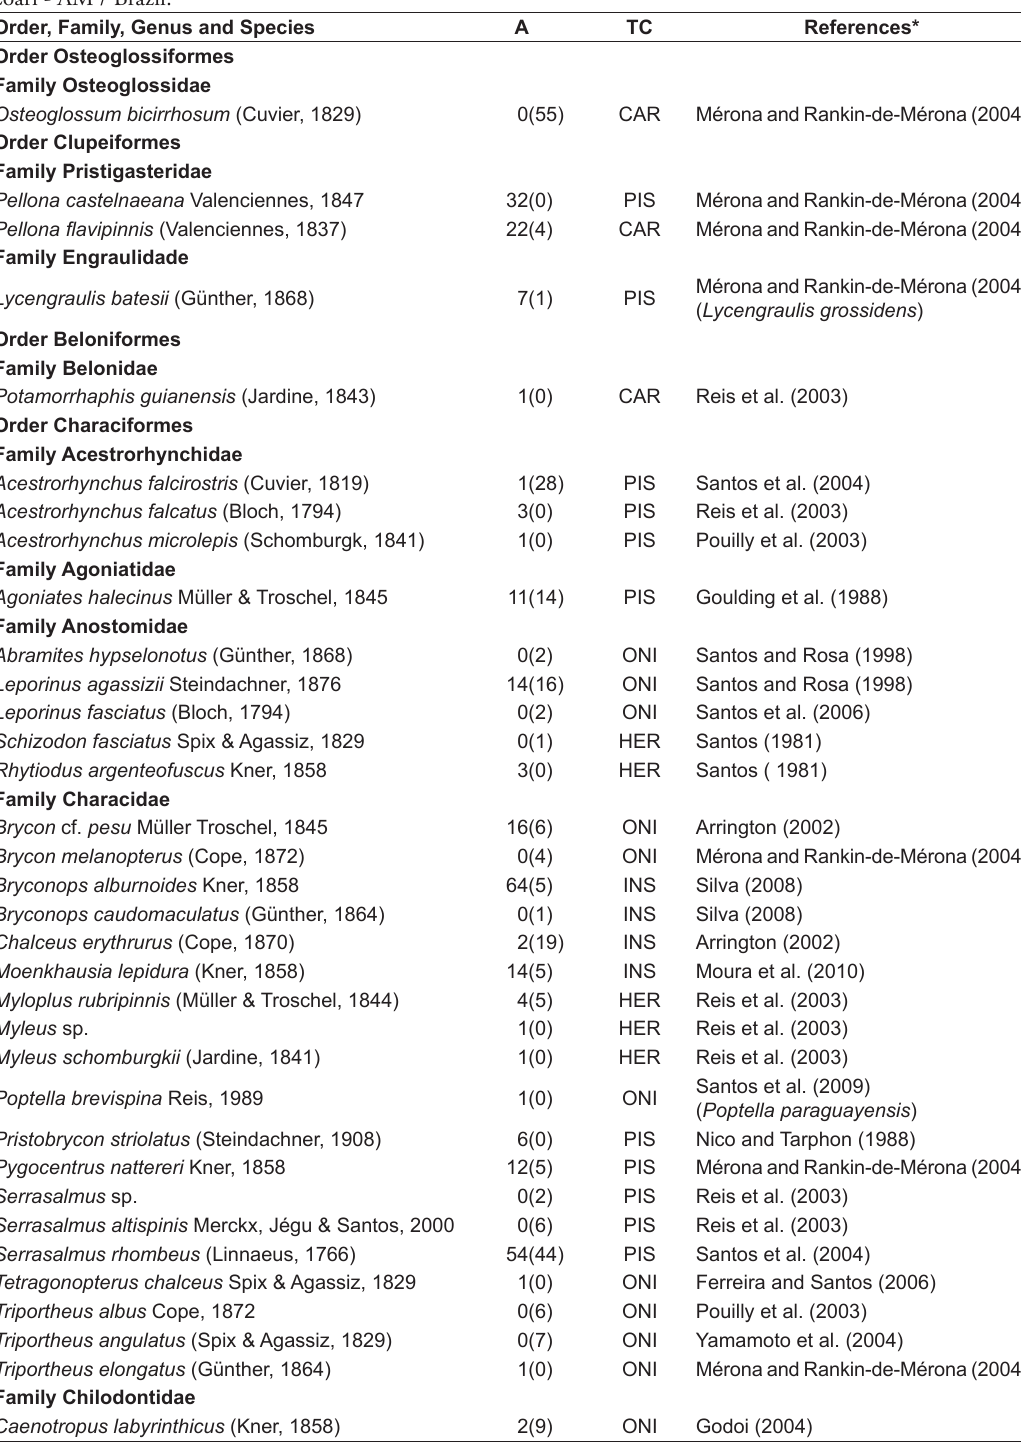
Table 2. Data of numerical abundance (A) during flood (dry) periods, trophic categorization (TC) (CAR=Carnivores, DET=Detritivores, HER=Herbivores, ILI=Iliophagous, INS=Insectivores, INV=Invertivores, ONI=omnivores, PIS=piscivores, PLA=planktivores) and references of the species collected in the Urucu River, municipality of Coari - AM /